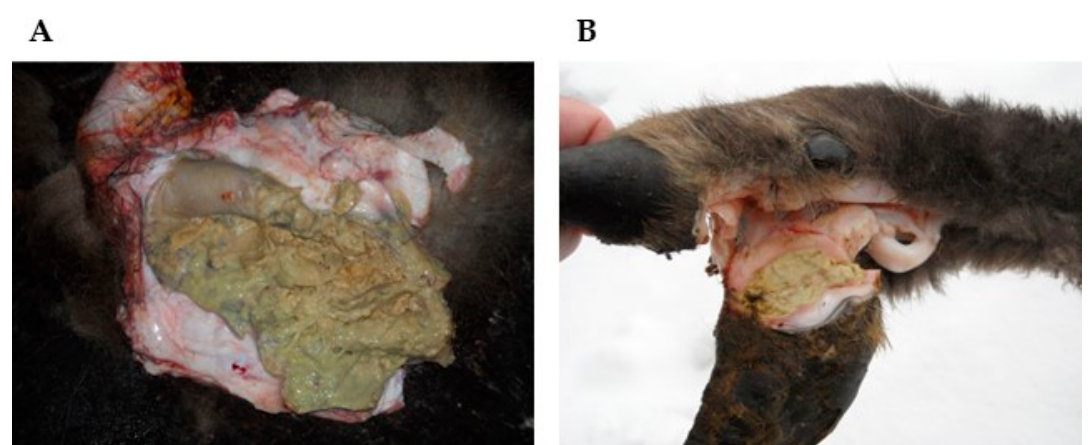
Figure 2. Examples of lesions related to T. pyogenes infections in European bison ( Bison bonasus ); ( A ): frequently occurred— balanoposthitis (the animal number 927), ( B ): rarely found—an interdigital abscess (the animal number 925).